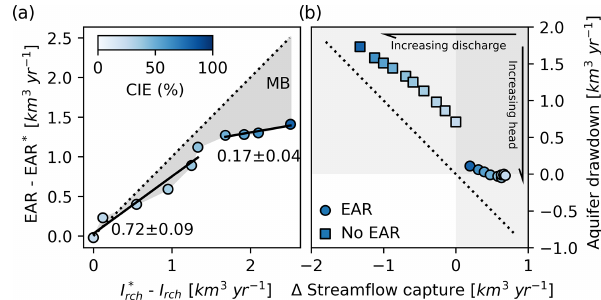
Figure 4. (a) Enhanced aquifer recharge (EAR) above the EAR re- quired at the baseline (EAR ∗ ) to ensure aquifer stabilization plotted against the reduction in net recharge from irrigation ( I rch ) from the baseline ( I ∗ ) as classical irrigation efficiency (CIE) increases. The rch dotted line represents equal increases in EAR and reductions in net recharge. All scenarios show that less additional EAR is required than is lost from net recharge as CIE increases; the magnitude is re- ferred to as the management benefit (MB). Slopes of piecewise lin- ear regressions (black lines) between two variables are shown with the standard error of the estimate. (b) Aquifer drawdown plotted against the change in basin streamflow capture ( Q ∗ − Q ) with the dotted line representing equal changes to discharge from baseline and